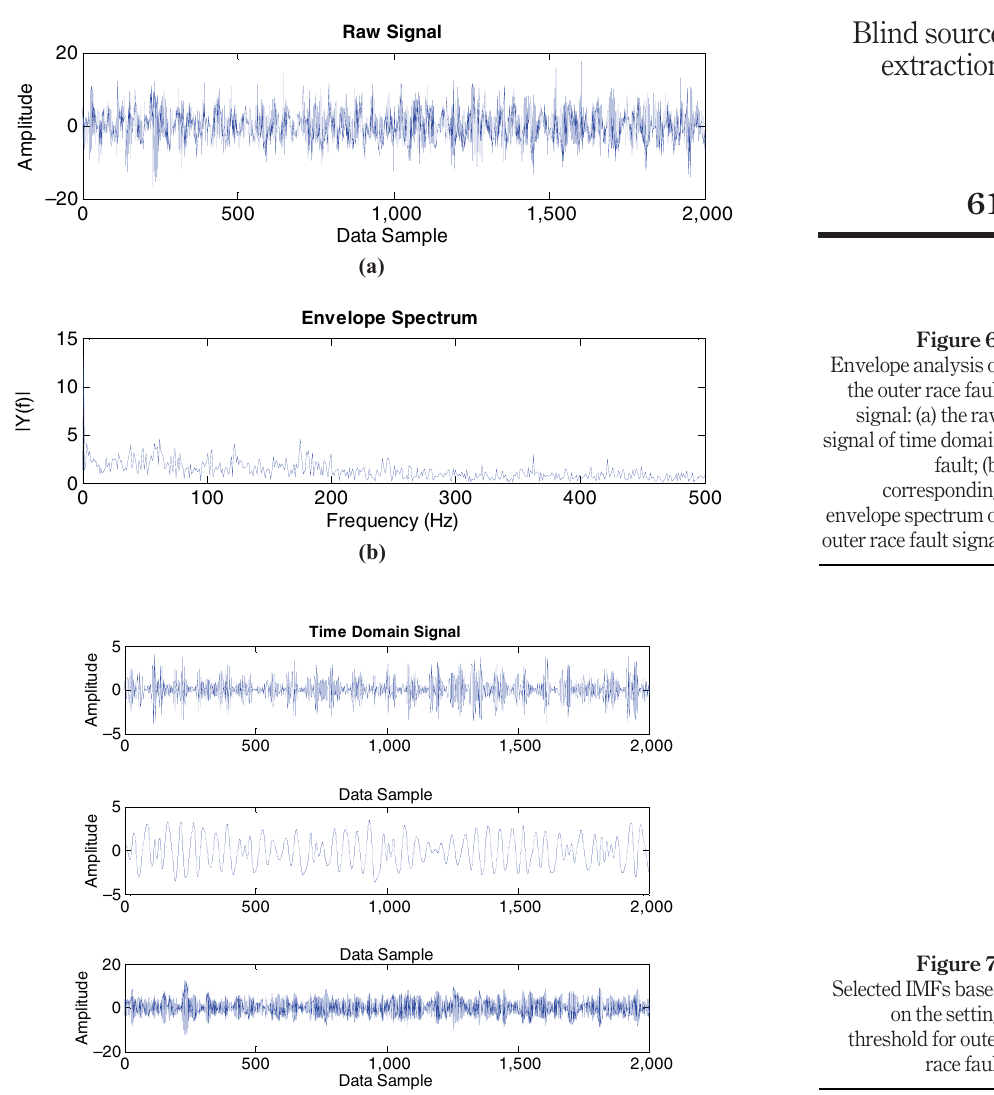
Figure 7. Selected IMFs based on the setting threshold for outer race